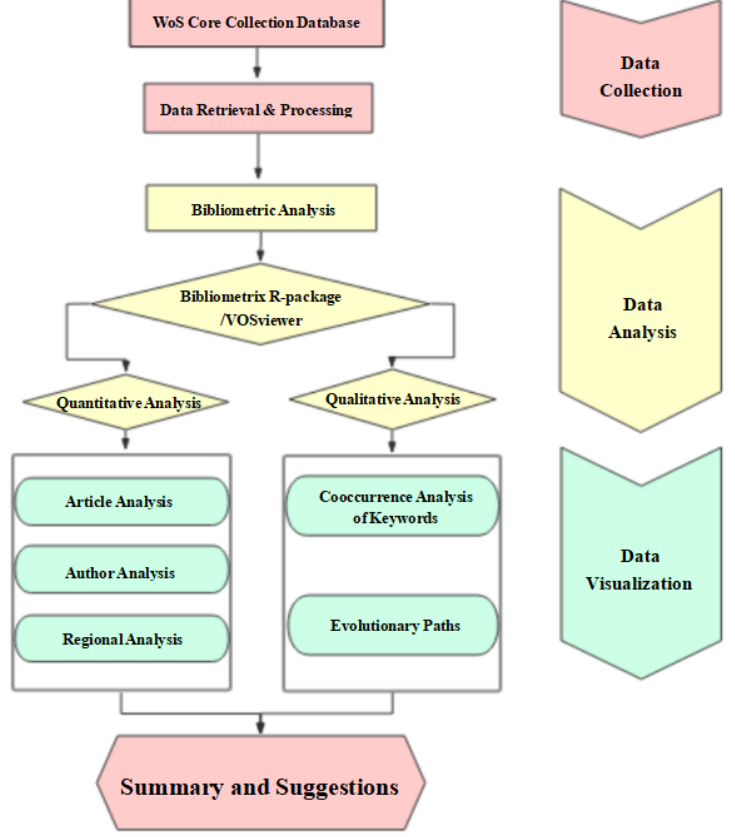
Figure 1. Bibliometrix and science-mapping